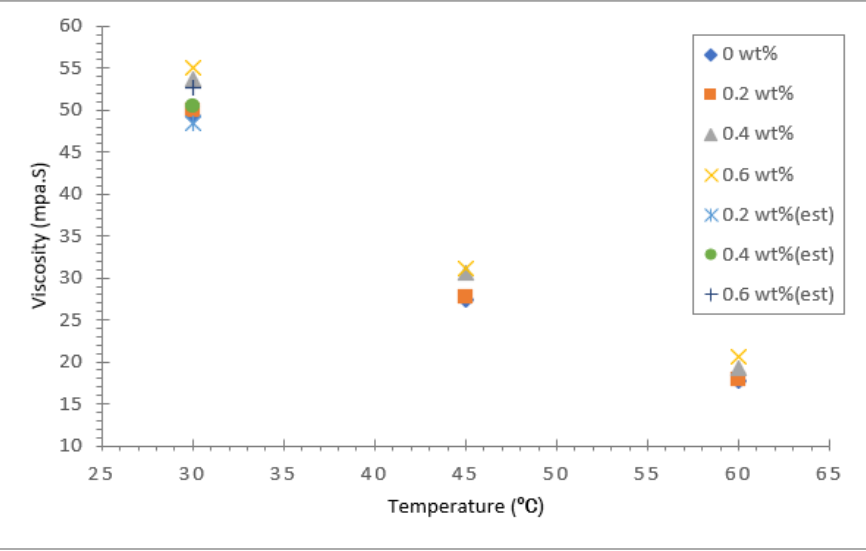
Figure 11. Dynamic viscosity of palm oil/Al 2 O 3 -TiO 2 hybrid nanofluid.